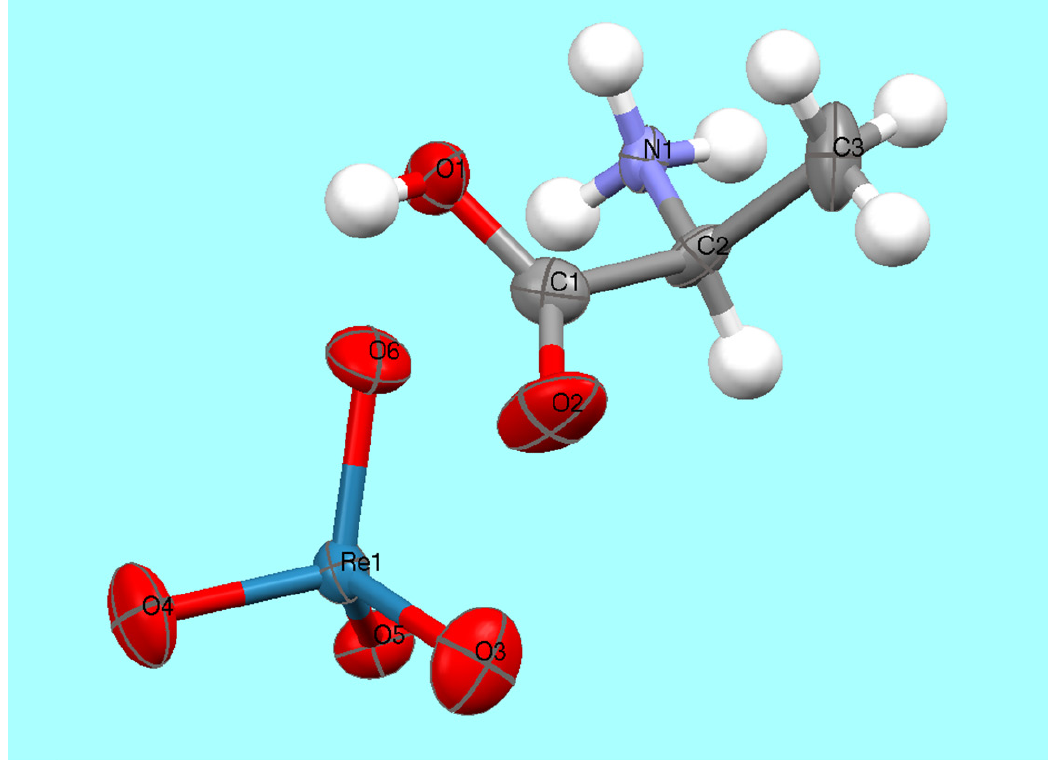
Figure 3. Asymmetric unit labeling and 50% vibration ellipsoids. Table 3. Torsion angles for LAlaRe